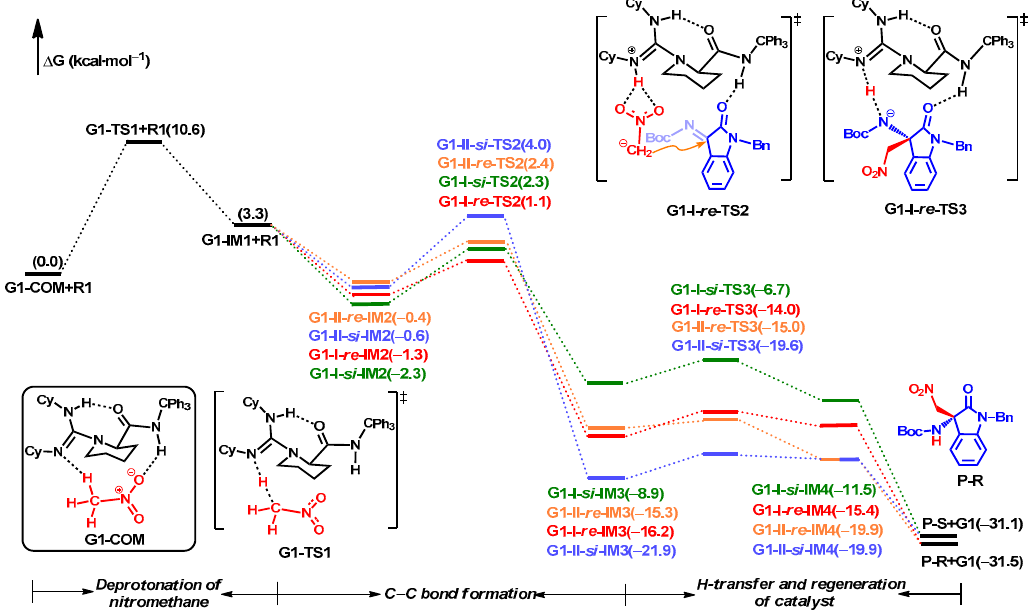
Figure 3. Energy profiles for aza-Henry reaction between N -Boc ketimine (R1a) and nitromethane (R2) catalyzed by guanidine (G1) along re - and si -face pathways in models I and II,